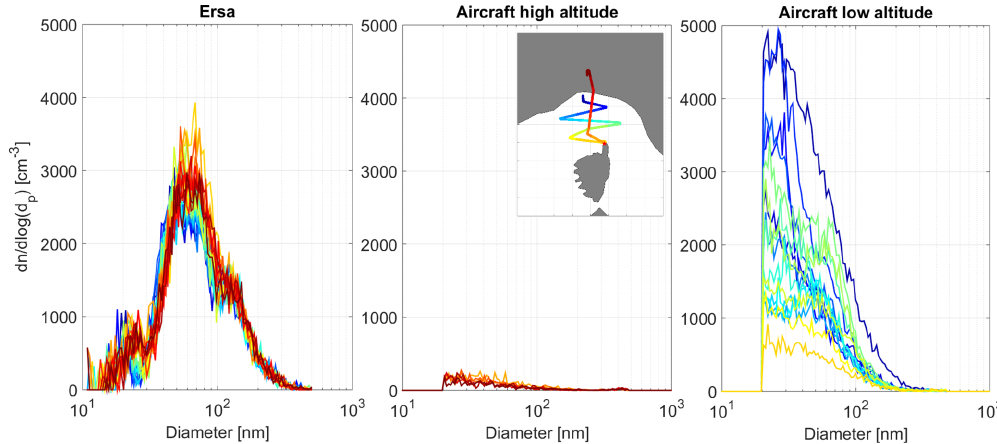
Figure 11. SMPS size distributions measured at Ersa (left panel) and onboard the ATR-42 at high altitude ( ∼ 3400ma . s . l . ) (middle panel) and low altitude ( ∼ 215ma . s . l . ) (right panel) on 30 July. The color coding of the size distributions corresponds to the location of the aircraft, as shown in the insert of the middle panel.